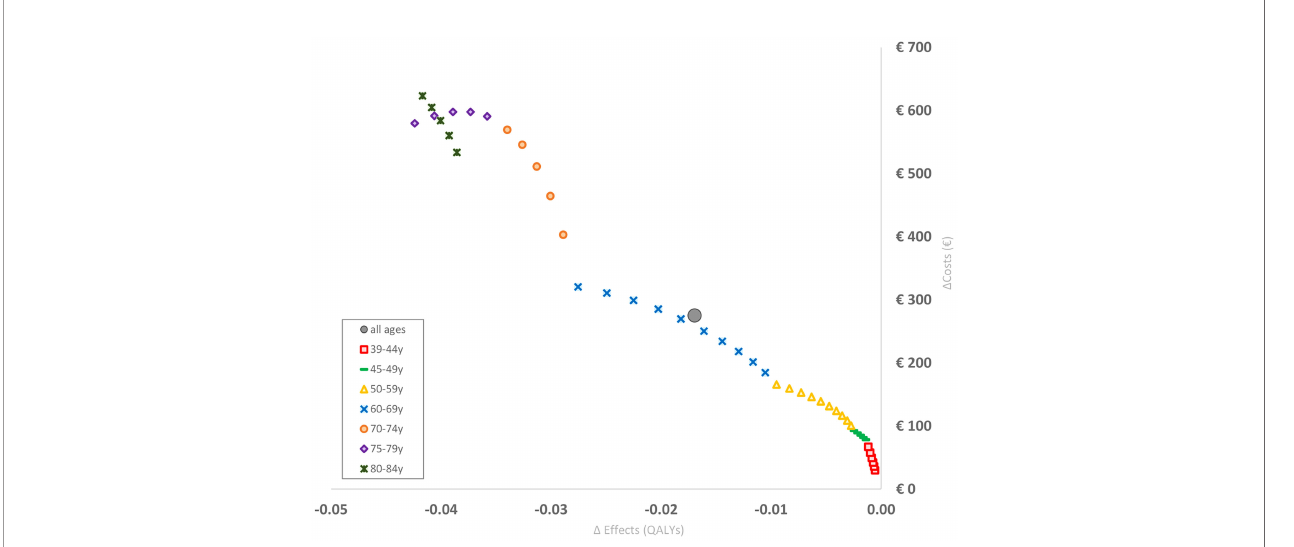
FIGURE 2 | Base case analysis. Each small point estimate represents the incremental cost and disutlity for a respective age (unweighted for age-speci fi c incidence rates) over a time horizon of 20 years after BC diagnosis, and shows the increasing trend with aging. The large point estimate indicates the mean incremental cost and disutility for all women in the cohort (i.e. D costs , € 275.10 and D disutility , 0.017 QALYs). BC, Breast Cancer; QALYs, Quality Adjusted Life Years; y,